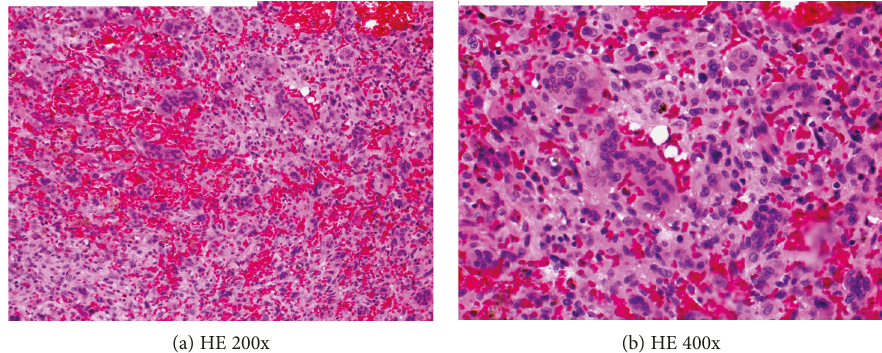
Figure 3: (a, b) Histopathologic examination demonstrating uniformly distributed multinucleated giant cells among mononuclear stromal cells; the nuclei of the giant cells and the stromal cells appear identical.